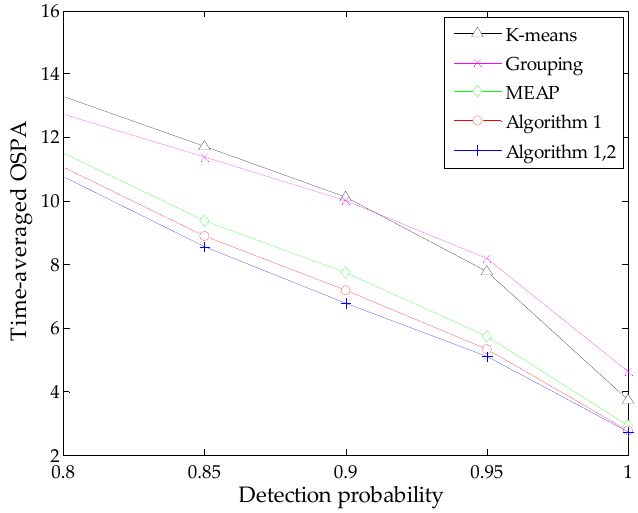
Figure 5. Time-averaged OSPA distance versus detection probability ( r “ 10).